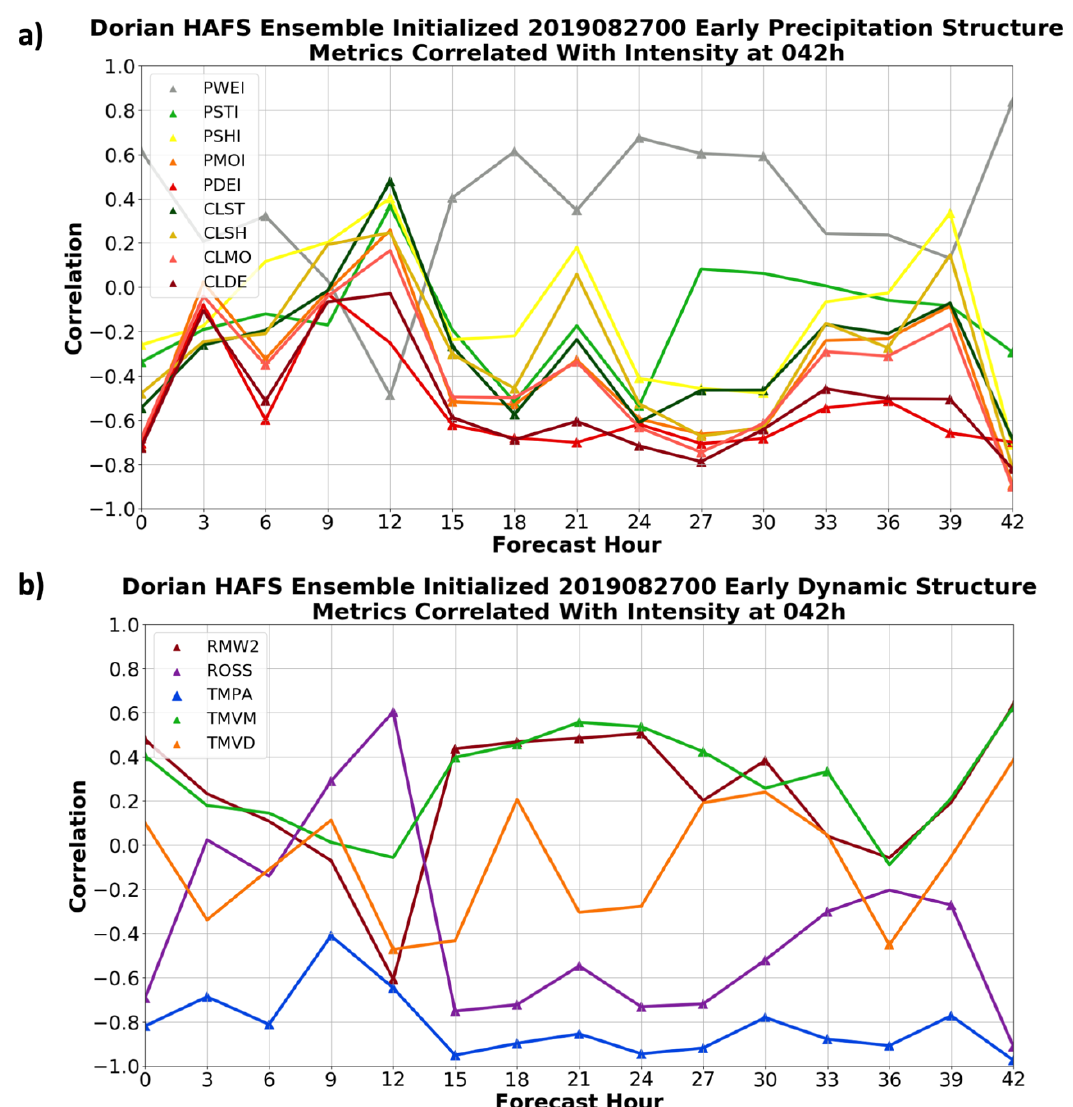
Figure 8. Correlations between all structure metrics from 0 to 42 h with the intensity (minimum pressure) of Dorian at 42 h. Forecast hours where the correlation is statistically significant ( p < 0.05) are shown with the triangles.